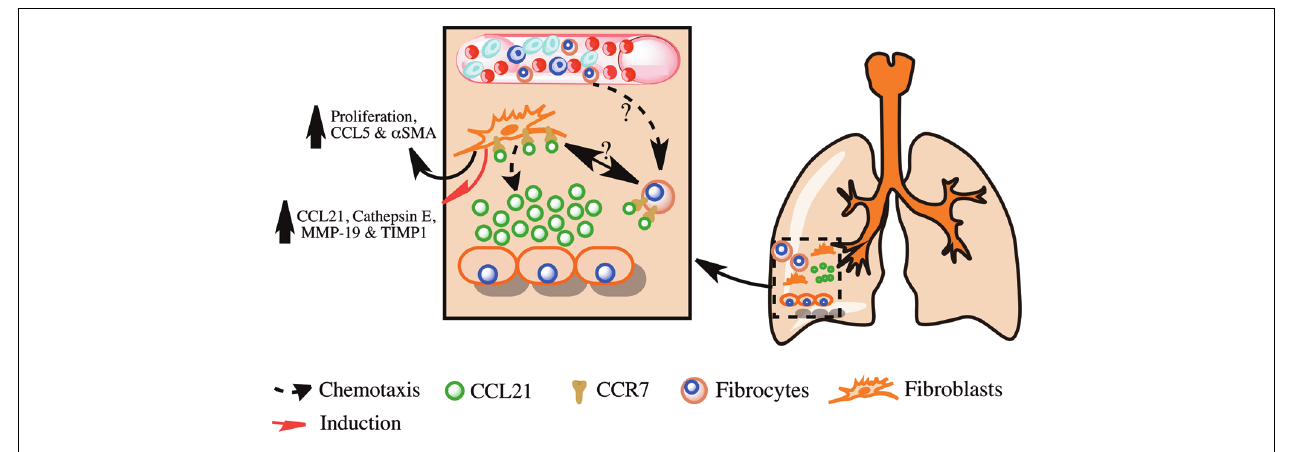
FIGURE 1 | Overview of the role of CCL21 and its receptor CCR7 in pulmonary fibrosis. Shown is a simplified overview of the role of CCL21 produced in fibrotic lungs in the promotion of pulmonary fibrosis via the recruitment and activation of lung fibroblasts and